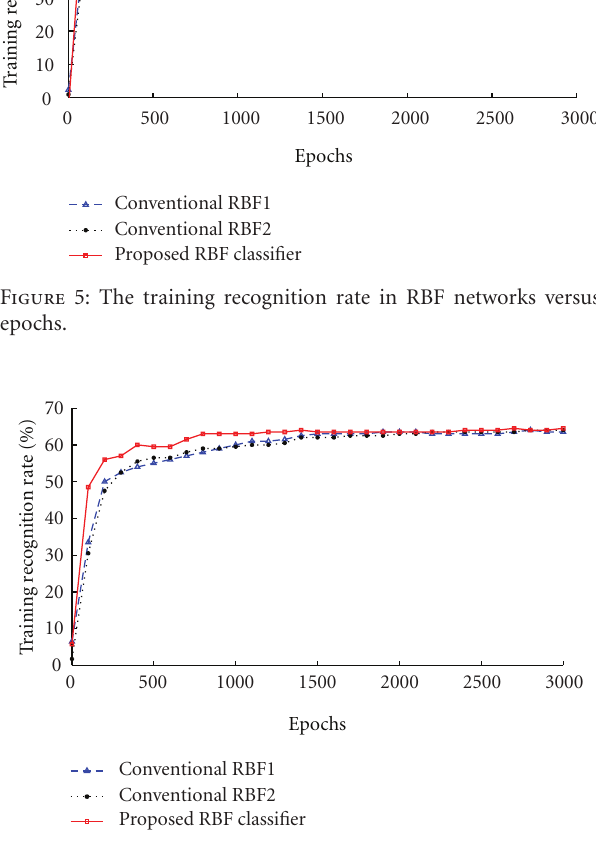
Figure 6: The testing recognition rate in RBF networks versus